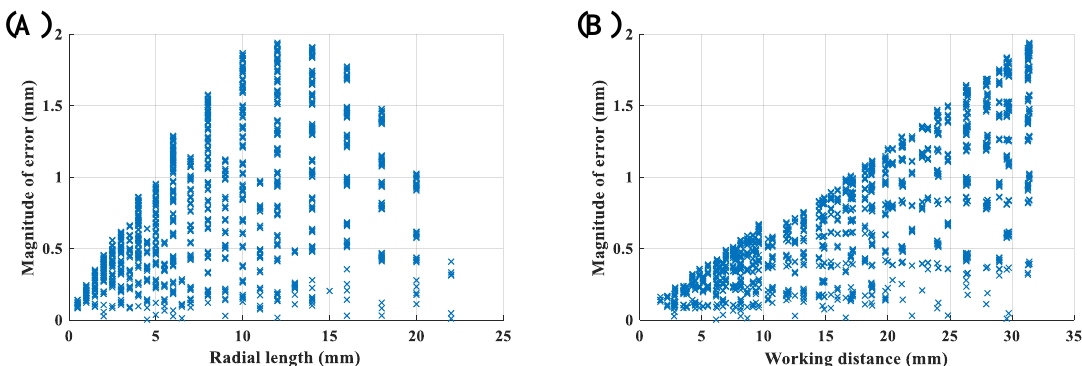
Figure 9. Performance of uniform model for radial measurements: (A) effect of object length, (B) effect of working distance.